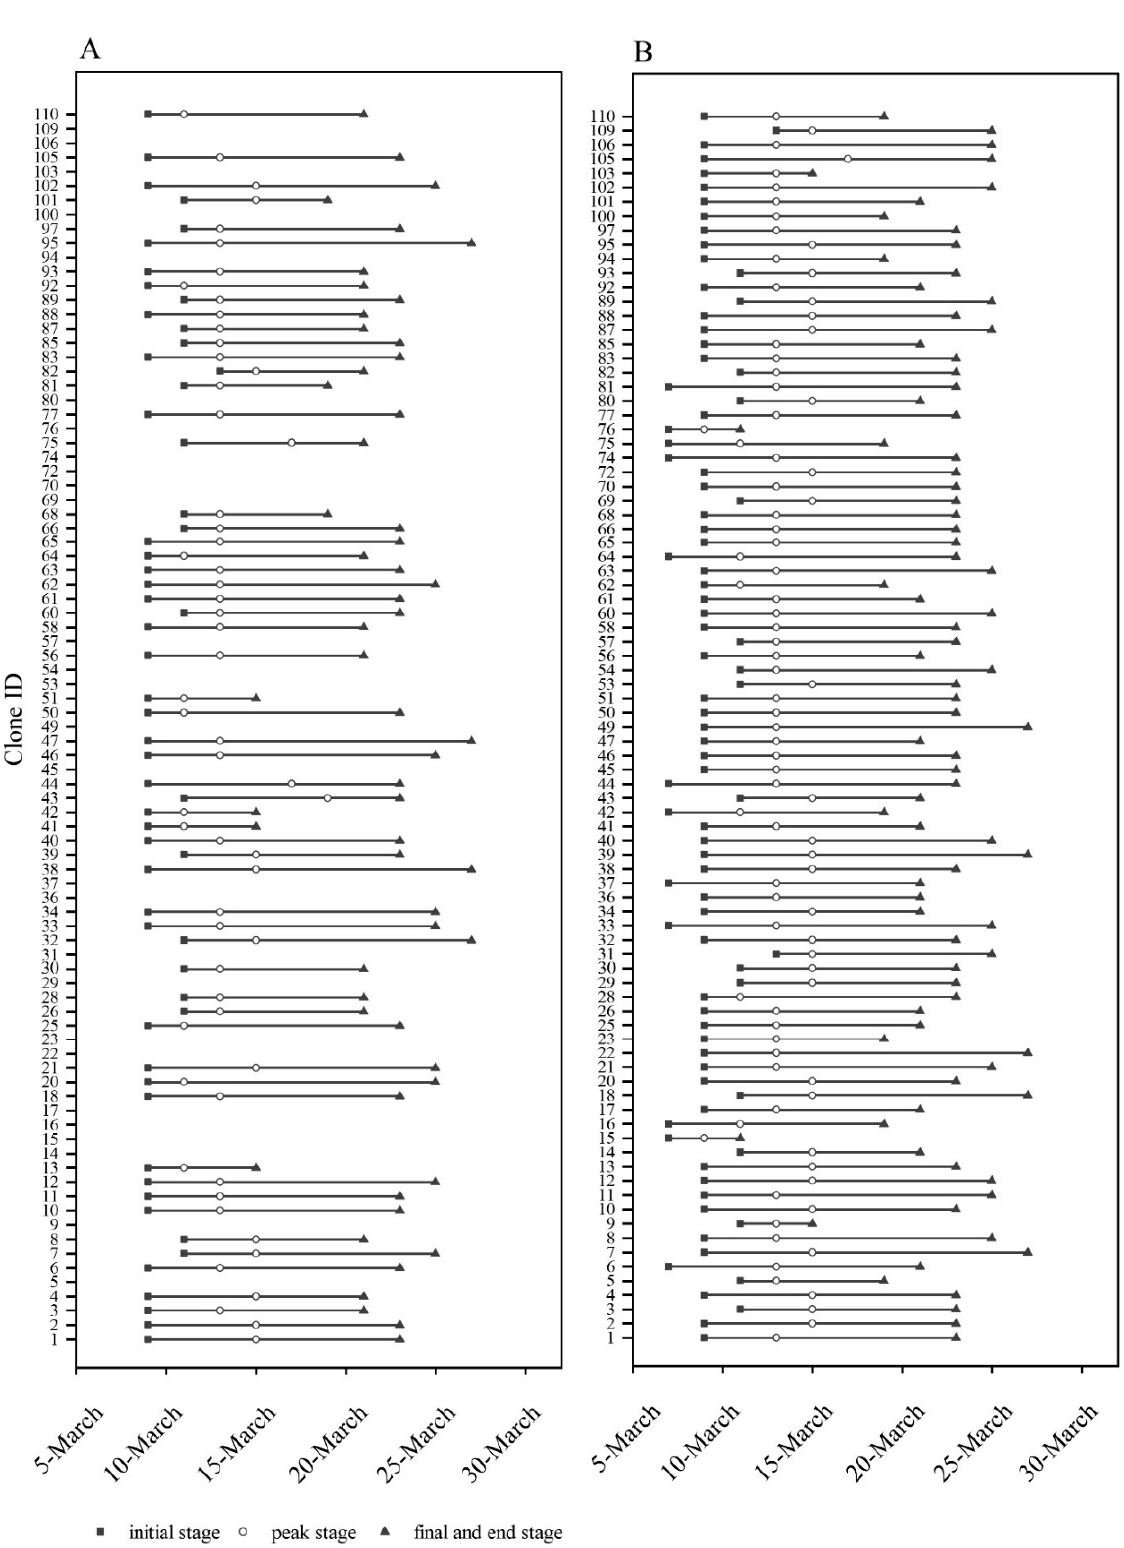
Figure 2. Period of flower receptivity ( A ) and pollen shedding ( B ) of the clones. Note: ( A ) shows the period of female flower receptivity at the initial, peak, and end stages of the clones in the seed orchard; ( B ) shows the period of pollen shedding at the initial, peak, and end stages of the clones in the seed orchard.